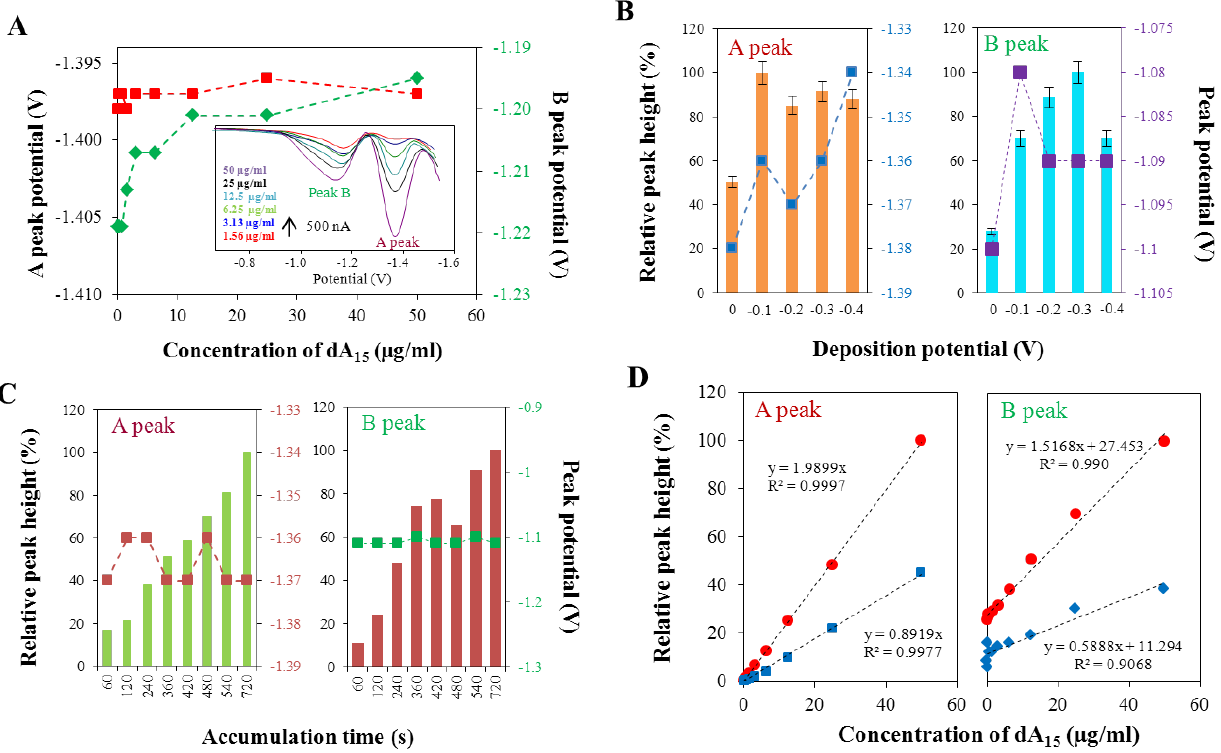
Figure 1. ( A ) Dependence of position of peak A and B of adenine-containing nucleotide dA15. Red points indicate potential values of peak A, green points indicate potential values of peak B, determined by square wave voltammetry with following parameters: start potential −0.1 V, end potential −1.6 V, deposition potential −0.1 V, accumulation time 720 s, equilibration time 5 s, voltage step 0.006 V, amplitude 0.02 V, frequency 280 Hz (sweep rate 1.6663 V/s). In inset: typical SW voltammograms of adenine-containing nucleotide dA15 at various concentrations; ( B ) Dependence of relative height and potential of peak A and B on the applied deposition potential for dA15 at concentration 25 µg/mL; ( C ) Dependence of a relative height and potential of peak A and B on the accumulation time for dA15 at concentration 25 µg/mL; ( D ) Influence of applied frequency on intensity of peak A and B for dA15 at concentration 25 µg/mL. Two different frequencies were applied, 100 (blue points) and 280 Hz (red